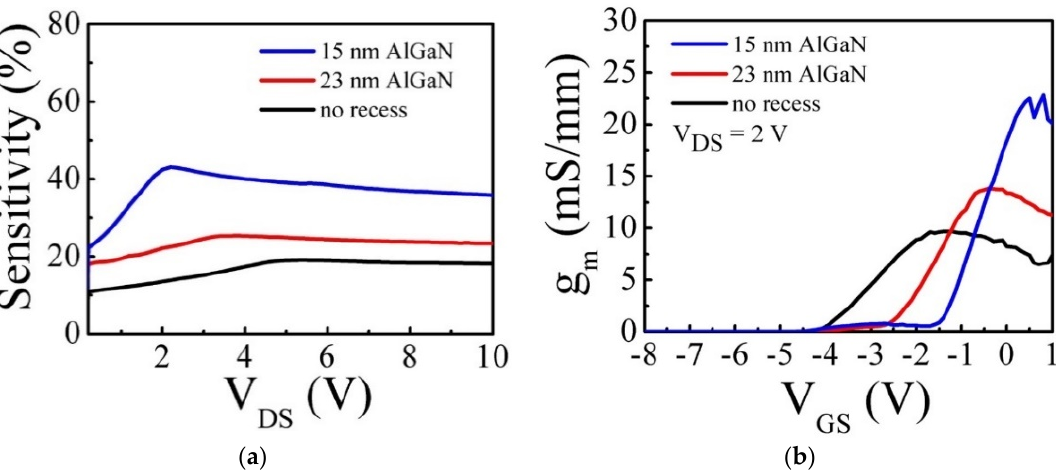
Figure 5. The dependence of ( a ) response with V GS = 0 V and ( b ) transconductance on AlGaN barrier thickness. Gas condition: 4%-H 2 in argon background gas, 200 °C. Table 1. Maximum response and transconductance dependence on AlGaN barrier thickness.